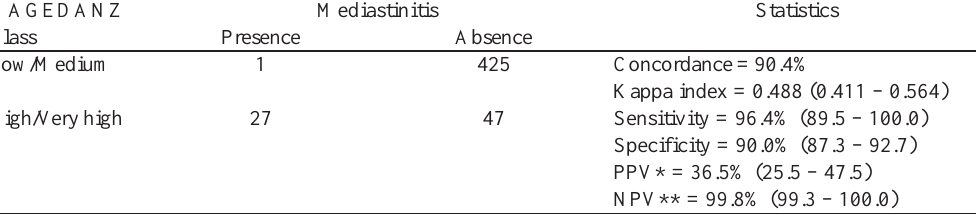
Table 6. Relationship between MagedanzSCORE and mediastinitis after CABG surgery using the cut-off defined as SCORE 2.